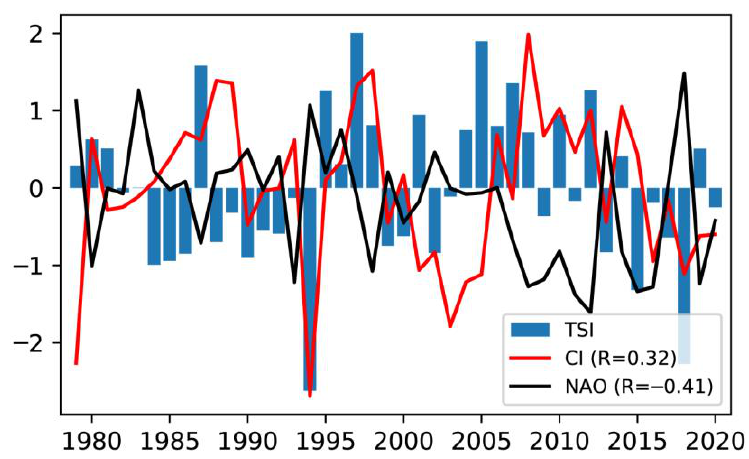
Figure 9. The normalized time series of the TSI (blue bar), the CI (red line) and the NAO index (black line) for 1979 – 2020. line) for